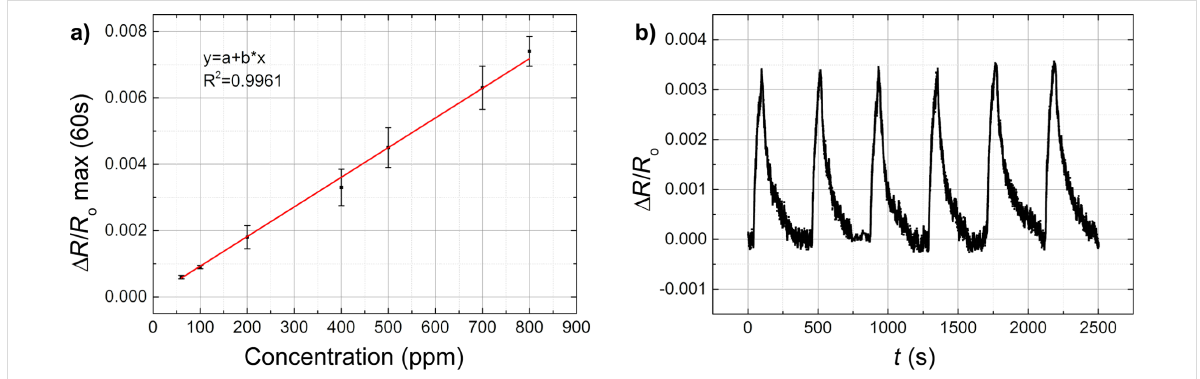
Figure 7: a) Δ R / R 0 max values of EVA–CB (7.75 phr CB) after 60 s exposure to various concentrations of benzene vapours. The error bars show the scattering for parallel sample measurements; b) Δ R / R 0 max values of one sample of EVA–CB (7.75 phr CB) repeatedly exposed to benzene vapours (400 ppm, 60 s). The sample thickness is 50 µm.